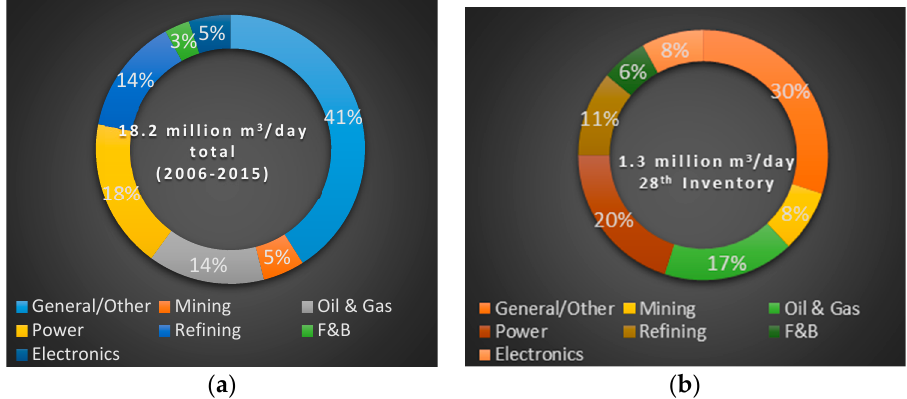
Figure 3. Total worldwide installed capacity by user type re-drawn from [26]. ( a ) Leading industries use desalination; ( b ) 28th Worldwide desalting plant inventory.